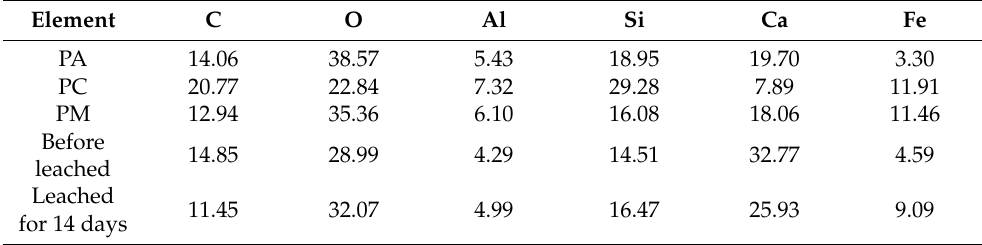
Figure 10. Energy spectrum diagram of B60 specimen at different zones after leaching. ( a ) PA ( b ) PC ( c ) PM. Table 8. Element content of leached B60 plastic concrete at different zones (wt.%).